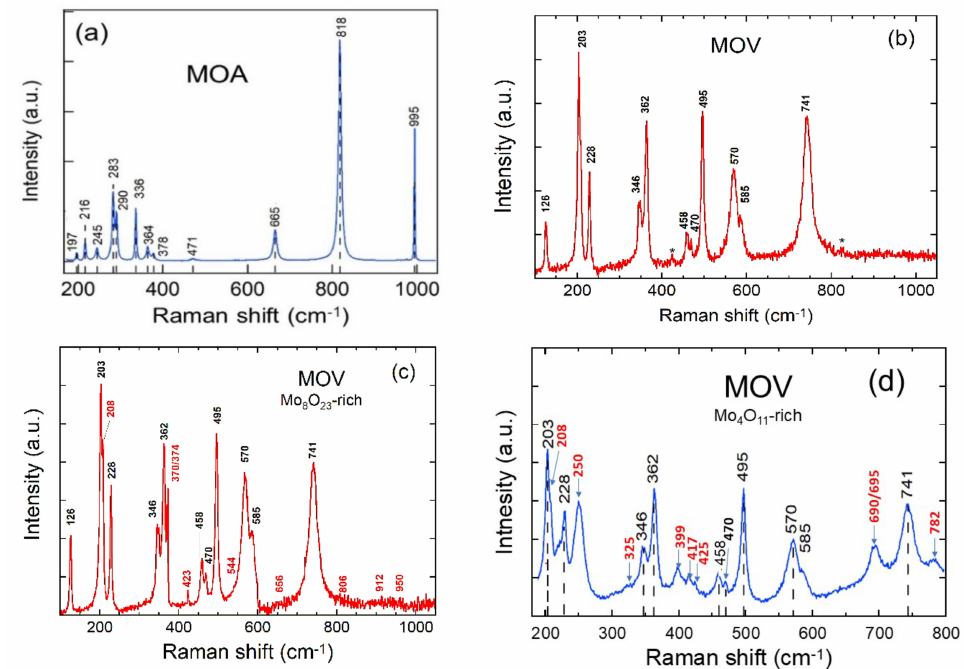
Figure 5. Raman spectra of the ( a ) MOA powders, ( b ) MOV (MoO 2 -rich sample where the stars correspond to Raman peaks of suboxides), ( c ) MOV with m-Mo 8 O 23 -rich particles, and ( d ) MOV with o-Mo 4 O 11 -rich particles. Spectra were recorded at a spectral resolution of 1 cm − 1 . Vibrational analysis of the MoO 2 spectrum reveals that the bands in the 500–800 and 200–400 cm − 1 regions were due to Mo–O stretching and bending modes, respectively. The low-frequency region (<200 cm − 1 ) corresponded to the lattice modes. The Raman